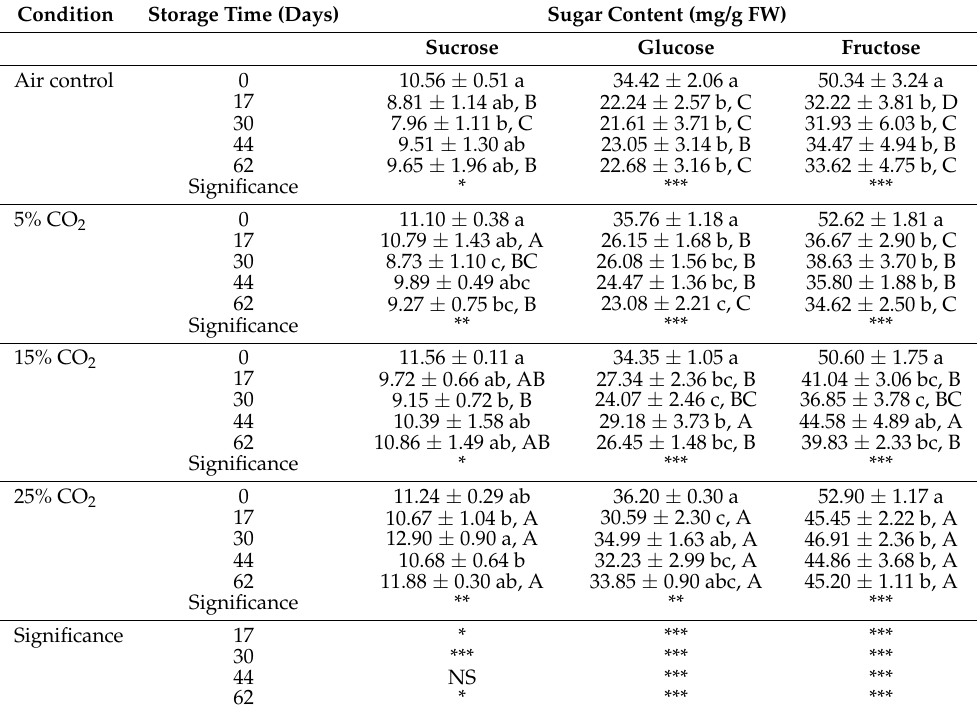
Data are means ± standard errors (five replicates per condition). Different lowercase letters (a–c) indicate statistically significant differences between storage durations within each CO 2 condition; different uppercase letters (A–D) indicate statistically significant differences between CO 2 conditions within each storage duration (Duncan tests; α < 0.05). *, p < 0.05; **, p < 0.01; ***, p <